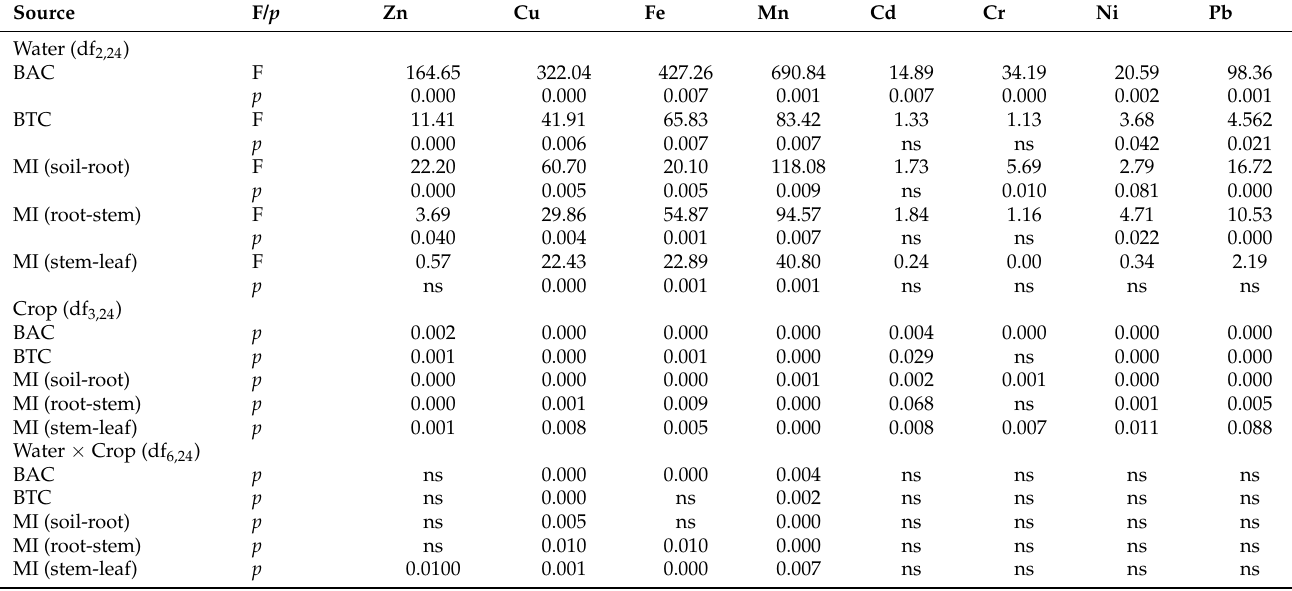
Table 3. Results of a two-way MANOVA for biological accumulation coefficient (BAC) and biological transfer coefficient (BTC) of studied crops, and mobility index (MI; soil-root, root-stem, and stem-leaf) of these crops irrigated with canal water, wastewater, and canal + wastewater in Multan.